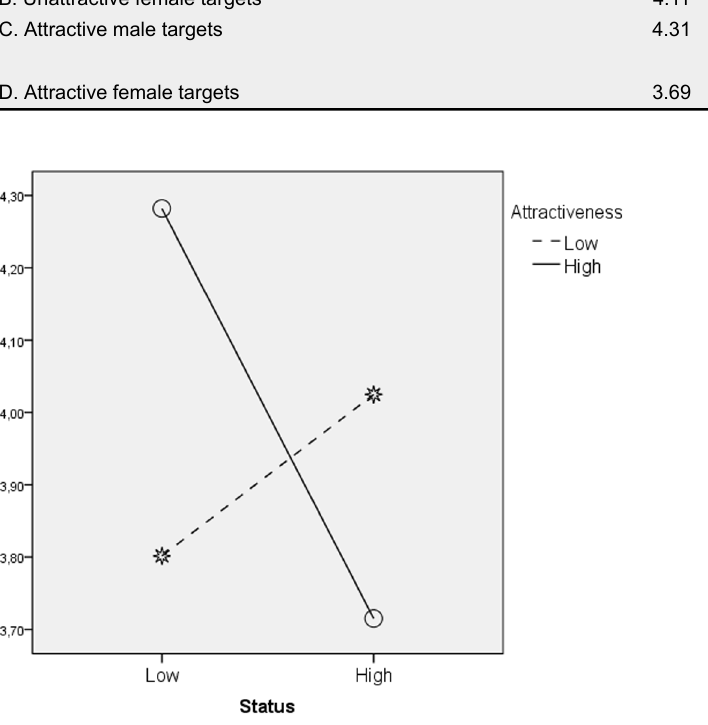
Figure 4. Interaction of status and attractiveness: Evaluation of the target in terms of openness mean scores.